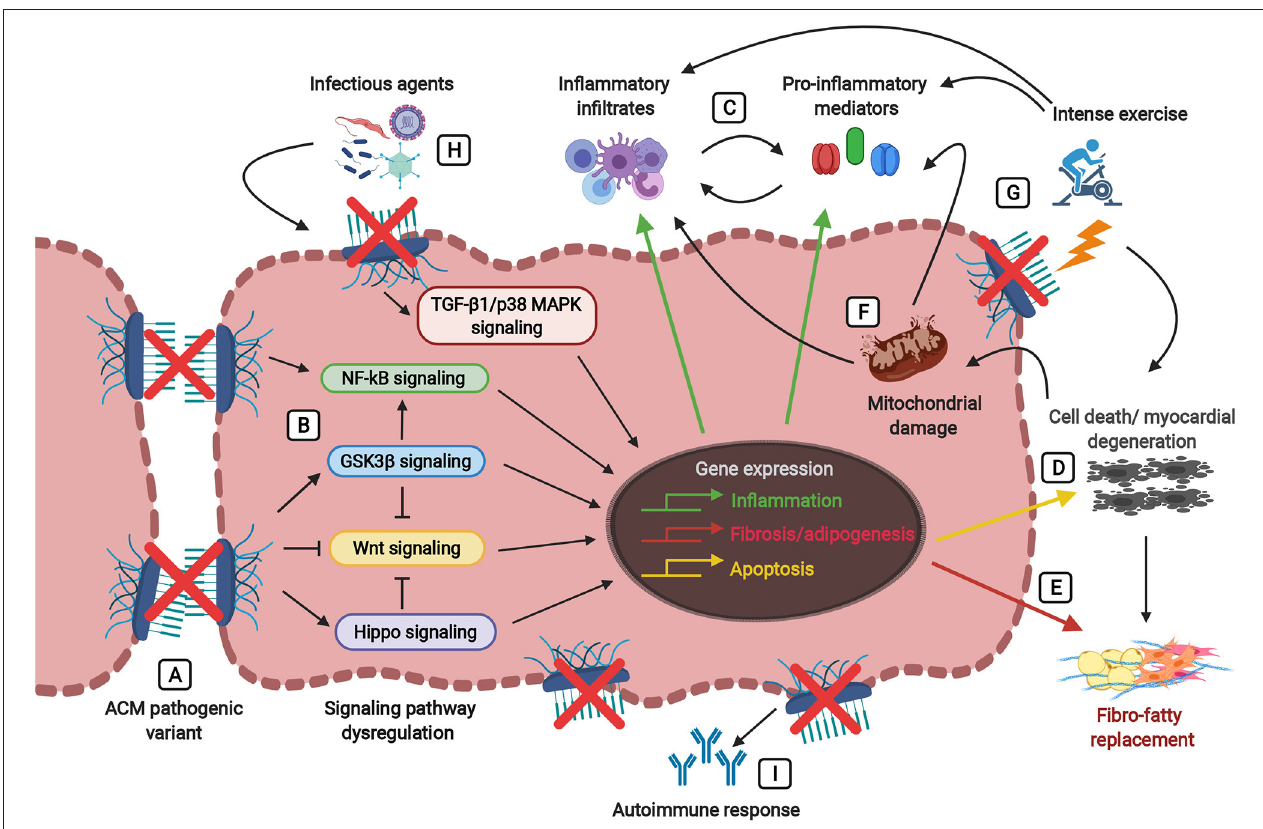
FIGURE 2 | Players involved in the inflammatory theory of ACM pathogenesis, ultimately leading to fibro-fatty replacement. Defects in the desmosomes caused by pathogenic mutations (A) trigger signaling cascades leading to the dysregulation of the Wnt pathway (inhibition) and the Hippo, GSK3 β , NF κ B, and TGF- β 1/p38 MAPK pathways (activation) (B) . Abnormalities in these signaling pathways lead to the activation of inflammatory, apoptotic, and fibrotic/adipogenic genes, thus resulting in the secretion of inflammatory cytokines (i.e., TNF- α , IL-1, IL-6, IL-8, IL-17) and the infiltration of inflammatory cells (i.e., T-lymphocytes, neutrophils, macrophages, mast cells) (C) and cellular damage associated with cardiac cell death (D) and fibro-fatty replacement (E) . During tissue injury and myocardial degeneration, damaged mitochondria release danger-associated molecular patterns (DAMPs, as reactive oxygen species (ROS) and mitochondrial (mt)DNA fragments), thus further precipitating the immune responses and perpetuating inflammation, apoptosis and fibro-adipogenesis (F) . Physical stress due to strenuous exercise not only causes mechanical injury and cell death in the presence of damaged desmosomes, but also stimulates the activation of the immune response and the production of pro-inflammatory mediators (G) . The myocardium carrying pathogenic alterations in genes encoding desmosomal proteins is more vulnerable to the presence of infectious agents (i.e., cardiotropic viruses, bacteria, protozoan), leading to the amplification of myocardial inflammation, severe myocyte damage and subsequent precipitation of the disease (H) . Desmosomal disruption and myocardial damage might stimulate an immune response by the production of auto-antibodies such as anti-DSG2 (desmoglein 2), AHA (anti-heart), and AIDA (anti-intercalated disk) antibodies (I)